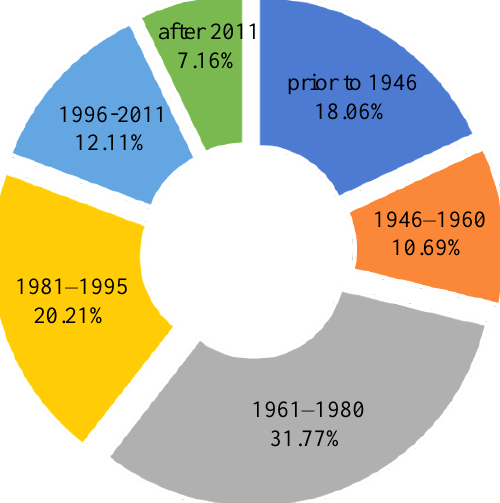
Figure 2. Structure of residential buildings in Poland in 2020 as divided according to the time of construction. Own research based on Central Statistical Office [56].